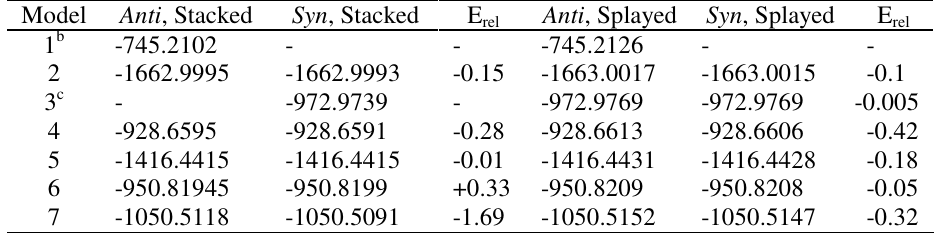
Table 3. Relative energies of stacked and splayed